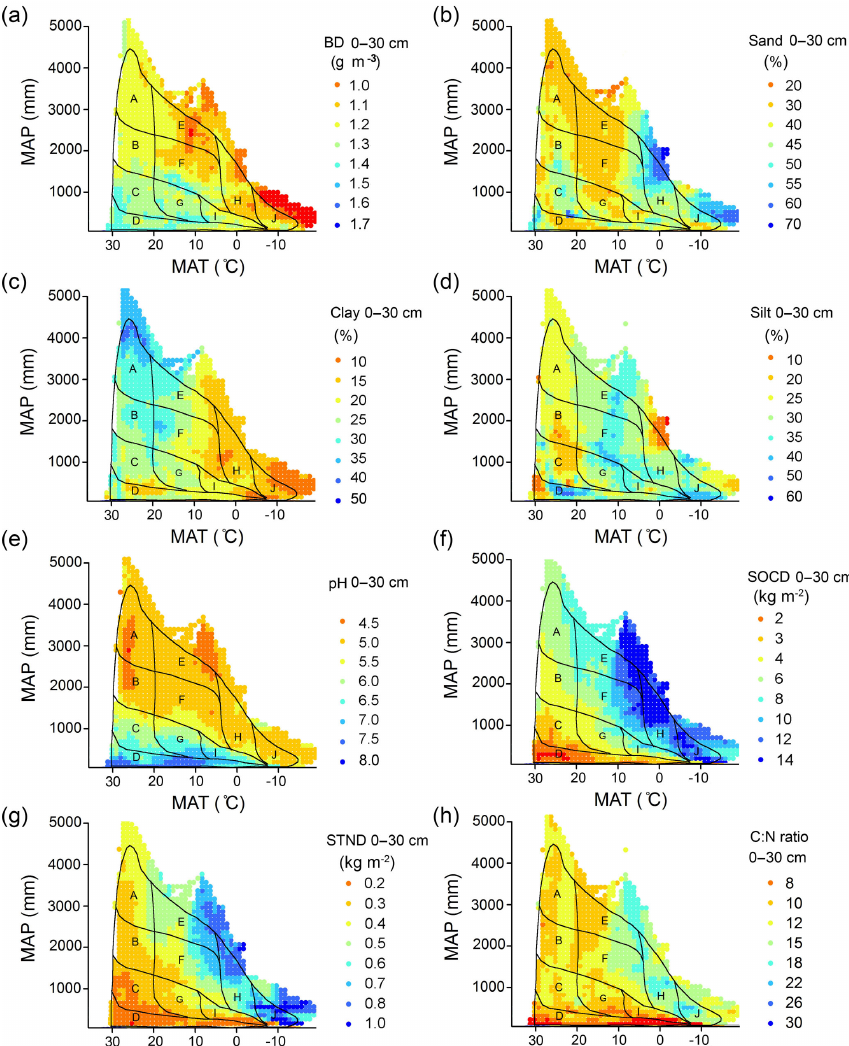
Figure 3. Changes in surface (0–30m) soil properties on the Whittaker biome diagram. (a) BD (bulk density, gm − 3 ), (b) sand fraction (%), (c) silt fraction (%), (d) clay fraction (%), (e) pH, (f) SOCD (soil organic carbon density, kgm − 2 ), (g) STND (soil total nitrogen density, kgm − 2 ) and (h) C : N ratio. Each square shows the average value of soil properties within each 1 ◦ C of MAT and 100mm of MAP. Each biome type in the modified Whittaker biome diagram is indicated by a capital letter. A: Tropical rainforest; B: Tropical seasonal forest; C: Tropical thorn scrub and woodland; D: Desert; E: Temperate rainforest; F: Temperate forest; G: Savanna; H: Boreal forest; I: Grassland; J: Tundra. curve (cold climate: STN = 0 . 0401 × MAP /( 1 + 0 . 0502 × MAP); warm climate: STN = 0 . 0015 × MAP /( 1 + 0 . 0021 × MAP ) ), showing a higher saturation threshold in cold cli- (Fig. 6d). Combining the trends of SOC density and STN density, the C : N ratio of the upper 30 cm layer increased with MAT in a climate of MAT < 0 ◦ C and then decreased (Fig. 6e). In contrast, the C : N ratio increased with MAP in accordance with a saturation curve (cold climate: C : N = 0 . 1450 × MAP /( 1 + 0 . 0080 × MAP ) ; warm climate: C : N = 0 . 3781 × MAP /( 1 + 0 . 0308 × MAP ) ), showing a higher